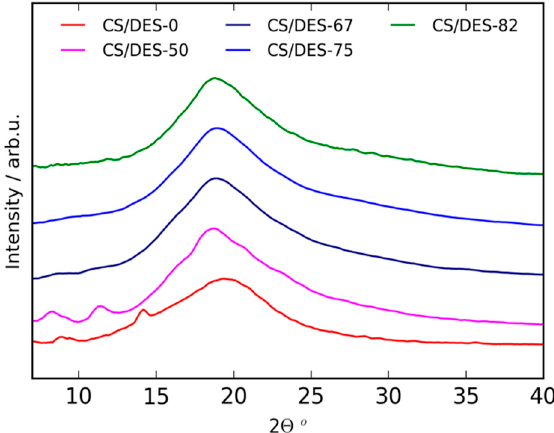
Figure 4. WAXD patterns of CS-LA film (CS/DES-0) and films with different NADES contents (50, 67, 75 and 82 wt%).